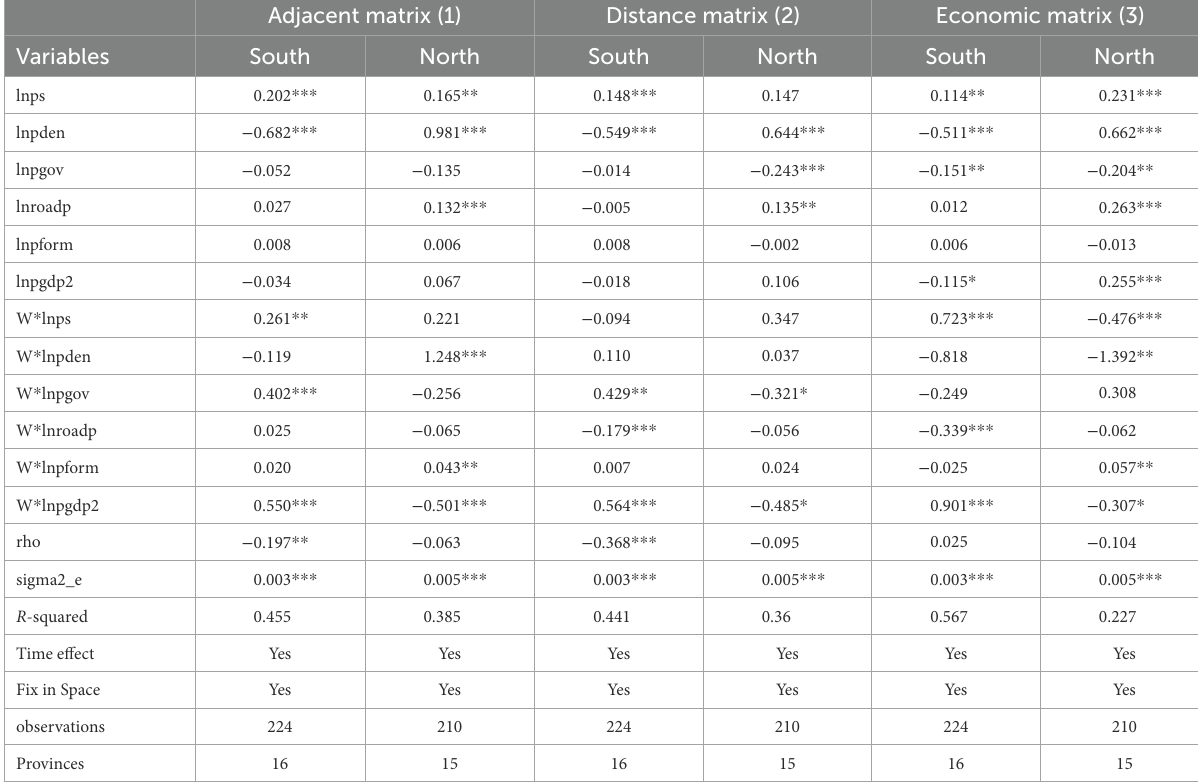
TABLE 5 Spatial econometric regression